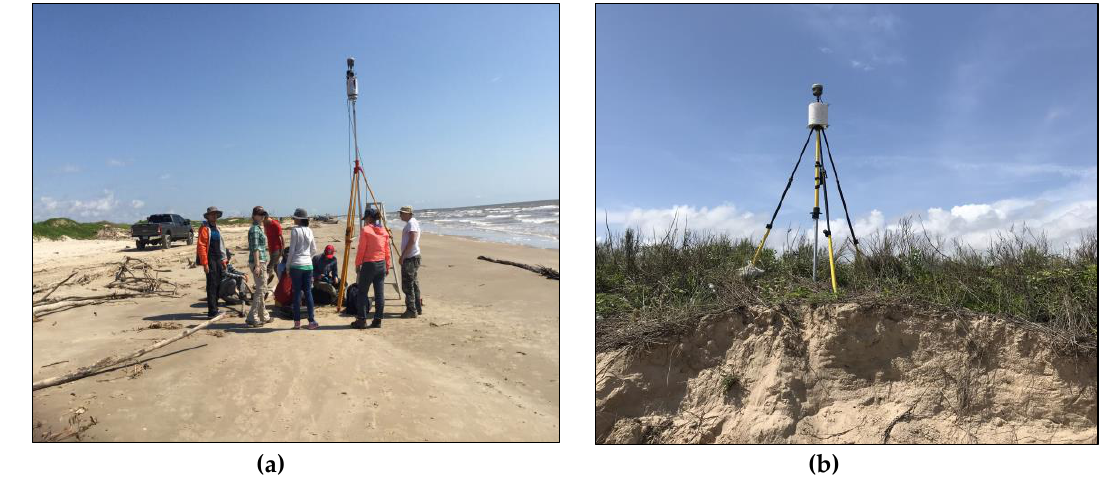
Figure 6. Photos showing field equipment used by the rapid TLS surveying method in the field. ( a ) A Riegl VZ-2000 scanner with a co-mounted Trimble R10 GPS unit; ( b ) a cylinder reflector with a co-mounted Trimble R10 GPS unit.